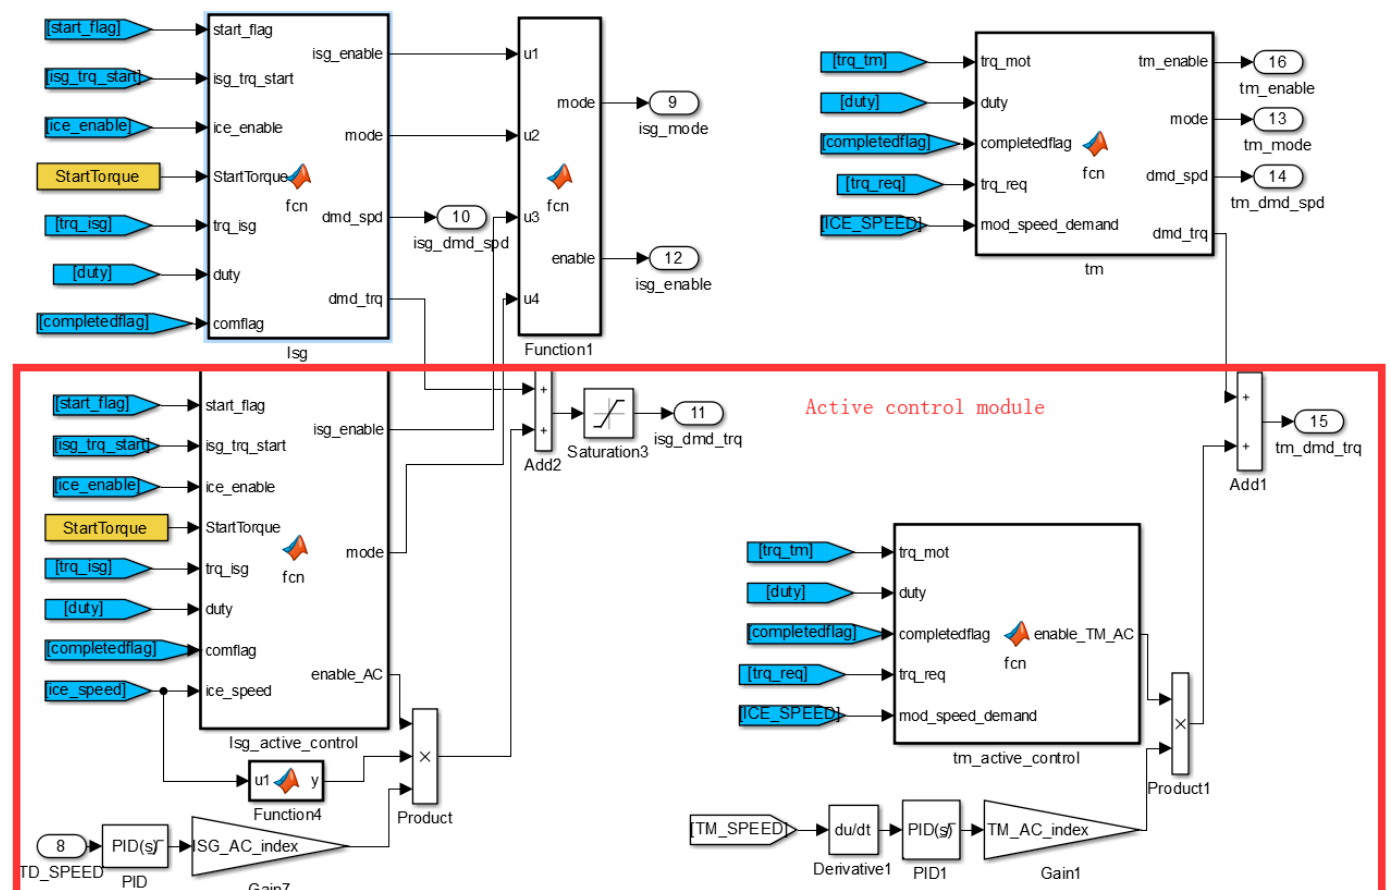
Figure A2. Control model in Simulink.